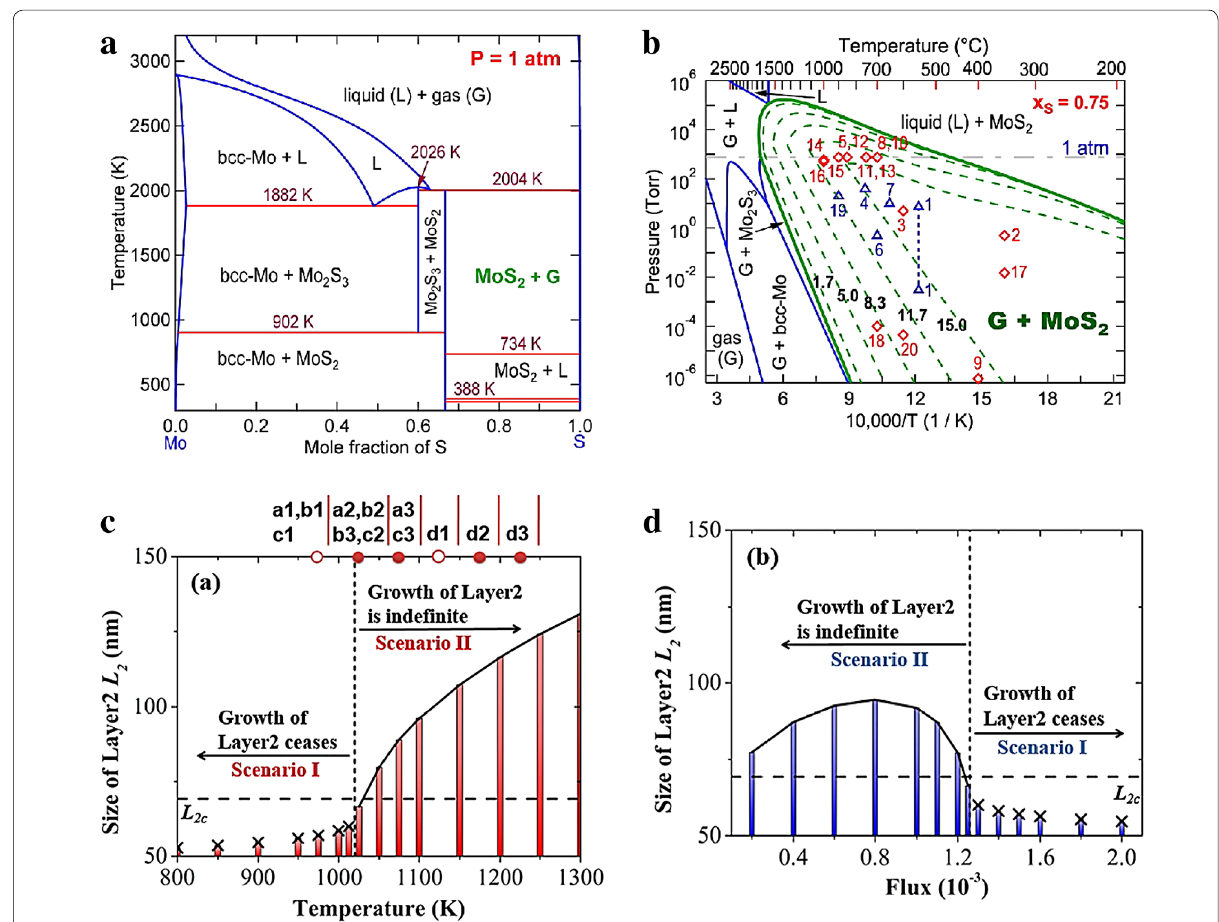
Fig. 2 Thermodynamics and kinetics during TMDs growth. a , b CALPHAD modeled temperature–composition (T–x), and pressure–temperature (P–T) phase diagram for the Mo–S system under pressure and under the S-rich condition respectively [56]. Copyright 2016, American Chemical Society. c Effect of temperature and, d precursor flux on the growth of layer 2 for 2 s [57]. Copyright 2017, American Chemical